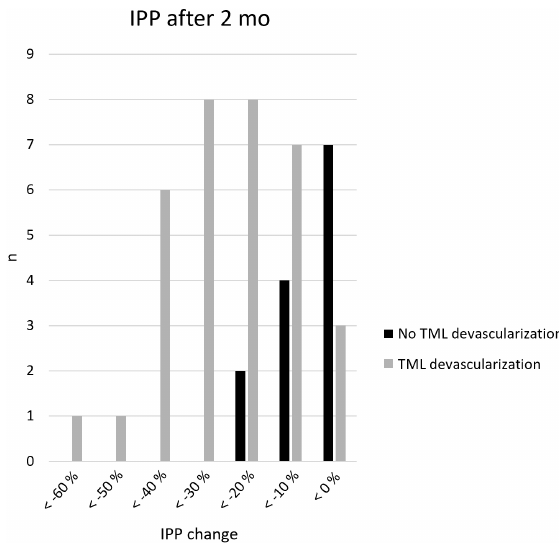
Fig. 5. Course of the intravesical prostatic protrusion (IPP) two month after the prostatic artery embolization (PAE). Ac- cordingly, to the TMLVol (Fig. 3), considerable IPP reduction was achieved after successful embolization of the TML: In 31 out of 34 cases (91.2%) IPP decreased significantly after successful TML devascularization. By contrast, without complete devasculariza- tion of the TML, IPP stayed indifferent or showed only a slight